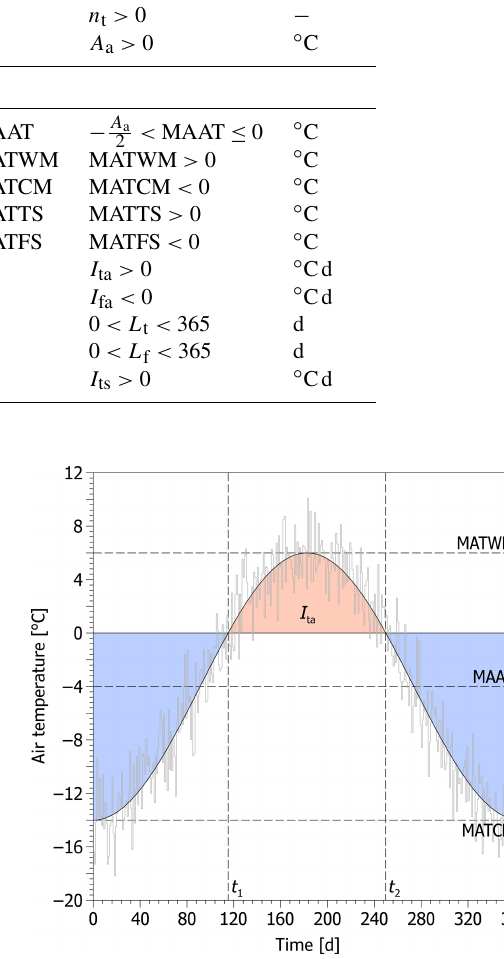
Figure 1. An idealized course of air temperature during the year described by a sine function with a mean of − 4 ◦ C and a range of 20 ◦ C (black solid line) superimposed on the annual air temperature curve with daily variations (grey solid line). The air thawing index is shown in red, while the blue areas depict partial air freezing in- dices for the preceding (left) and subsequent (right) freezing season, respectively. See the text and Table 1 for